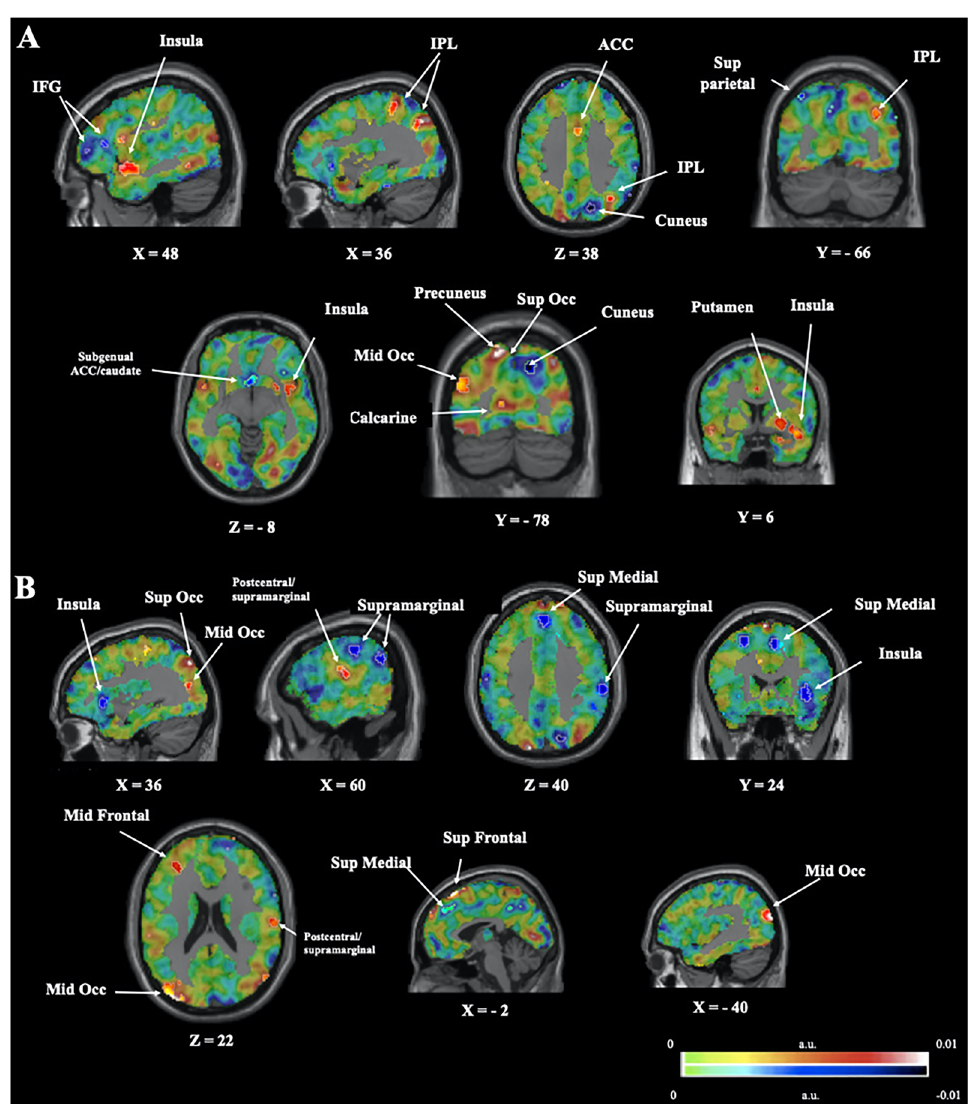
Fig. 2 Weight map of positive and negative voxel-wise weight contribution in the classification of HC versus BD. A: Negative Decrease HC versus BD. B: Neutral Decrease HC versus BD. Highlighted region depicts contribution of the top 5% positive (red) and negative (blue) weights, with a minimum extent of 5 voxels. Abbreviations are as follows: a.u. arbitrary units; Mid Occ middle occipital cortex; Sup Occ = = IFG inferior frontal gyrus; IPL inferior parietal lobe; ACC anterior cingulate cortex; Mid frontal; middle frontal; Sup Medial = = = Frontal superior frontal. Images are shown in neurological convention (i.e. right hemisphere is on the =